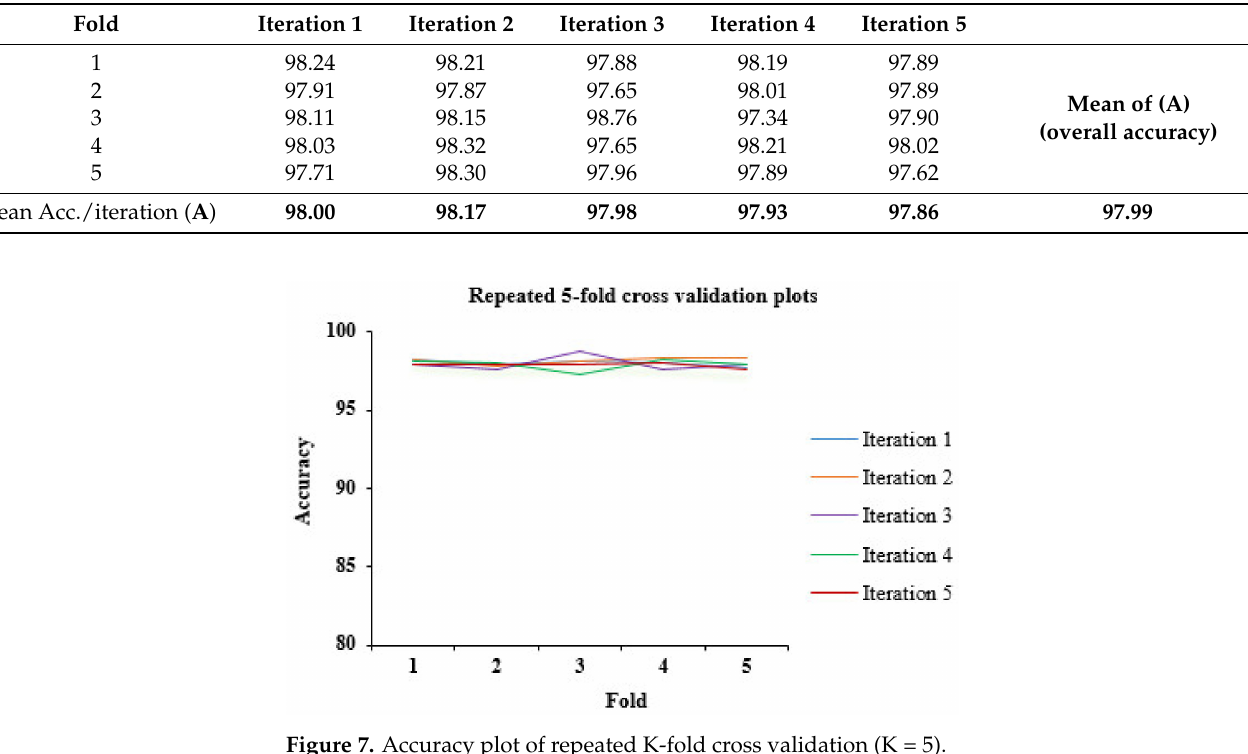
Figure 6. ROC curve of the proposed ensemble model. Table 7. Repeated five (05)-fold cross-validation results.